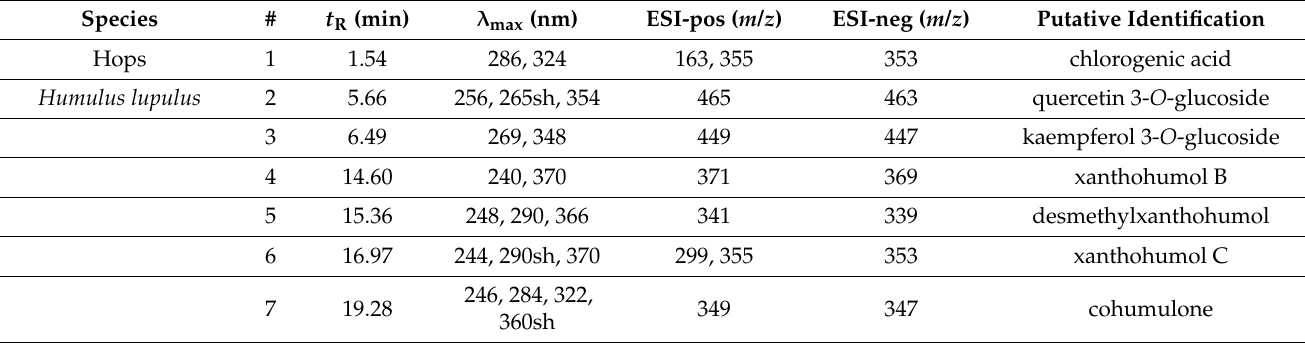
Table 4. Chromatographic and spectral characteristics of major peaks in the UHPLC-DAD-ESIMS chromatograms of the EtOH extracts of the herbs. Peak numbering is restarted for each herb